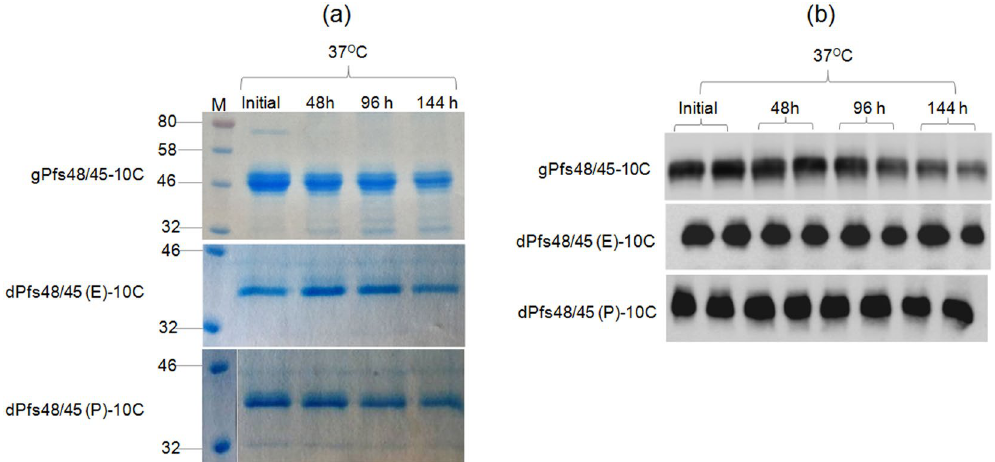
Figure 4. Stability of glycosylated and deglycosylated Pfs48/45-10C variants. ( a ) Plant produced, FLAG antibody affinity column purified glycosylated (gPfs48/45-10C) or in vivo Endo H (dPfs48/45 (E)-10C) or PNGase F (dPfs48/45 (P)-10C) deglycosylated forms of Pfs48/45-10C variants were incubated at 37 °C for 48, 96 and 144 hours, and analyzed in SDS-PAGE. Lanes were loaded with ~2.0 μ g (gPfs48/45-10C) or ~1.5 μ g (dPfs48/45 (E)-10C or dPfs48/45 (P)-10C) of protein. M: color prestained protein standard. ( b ) Hundred ng per lane of Pfs48/45-10C proteins were run in SDS-PAGE prior to western blotting. Proteins on the blot were probed with anti-FLAG antibody. The image was taken using the highly sensitive GeneGnome XRQ Chemiluminescence imaging